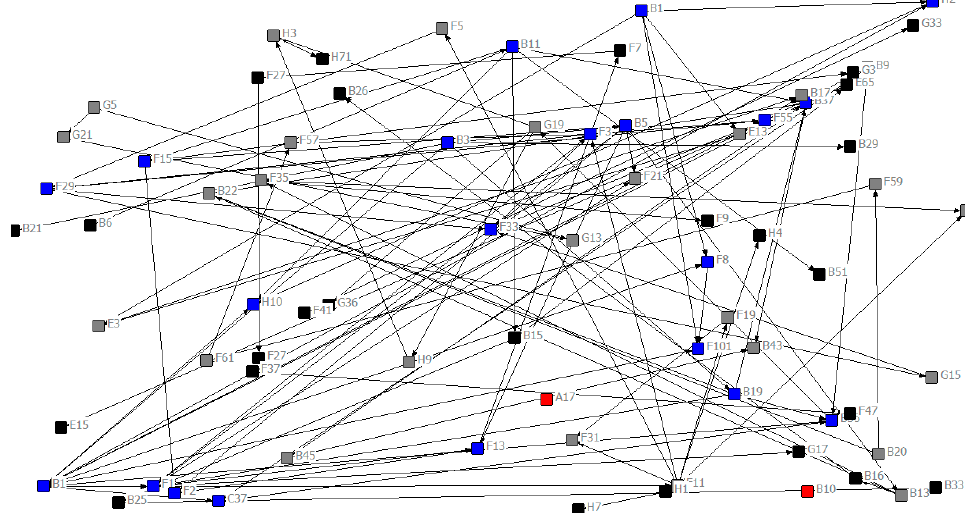
Figure 2. Knowledge-based network visualization of Heng Sheng electronics in 2015 .